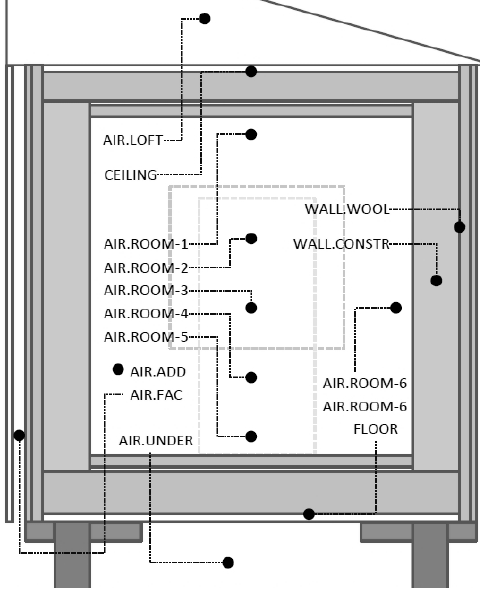
Fig. 2. Locations of T/H sensors in a test